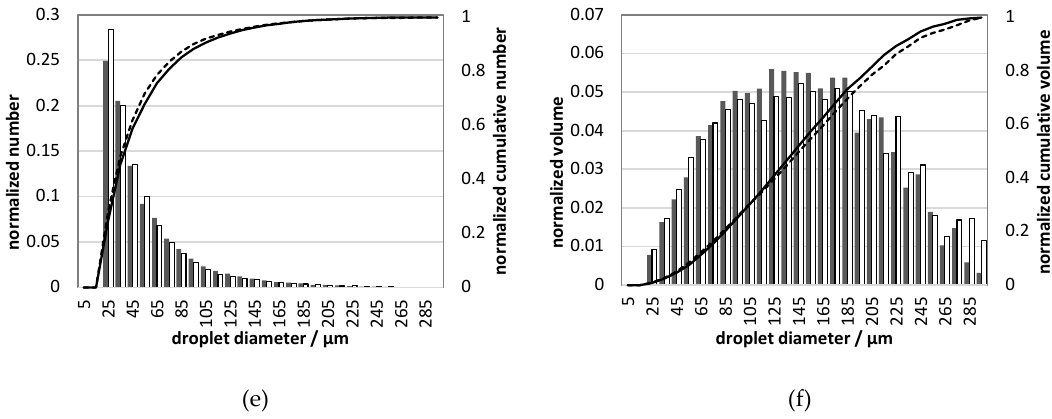
Figure 10. Droplet size distribution for UWS and water for different injection pressures (gauge): ( a ) number, 0.5 MPa; ( b ) volumetric, 0.5 MPa; ( c ) number, 0.45 MPa; ( d ) volumetric, 0.45 MPa; ( e ) number, 0.4 MPa; ( f ) volumetric, 0.4 MPa; legend shown in (a) is valid also in (c,e); legend shown in (b) is valid also in (d,f).